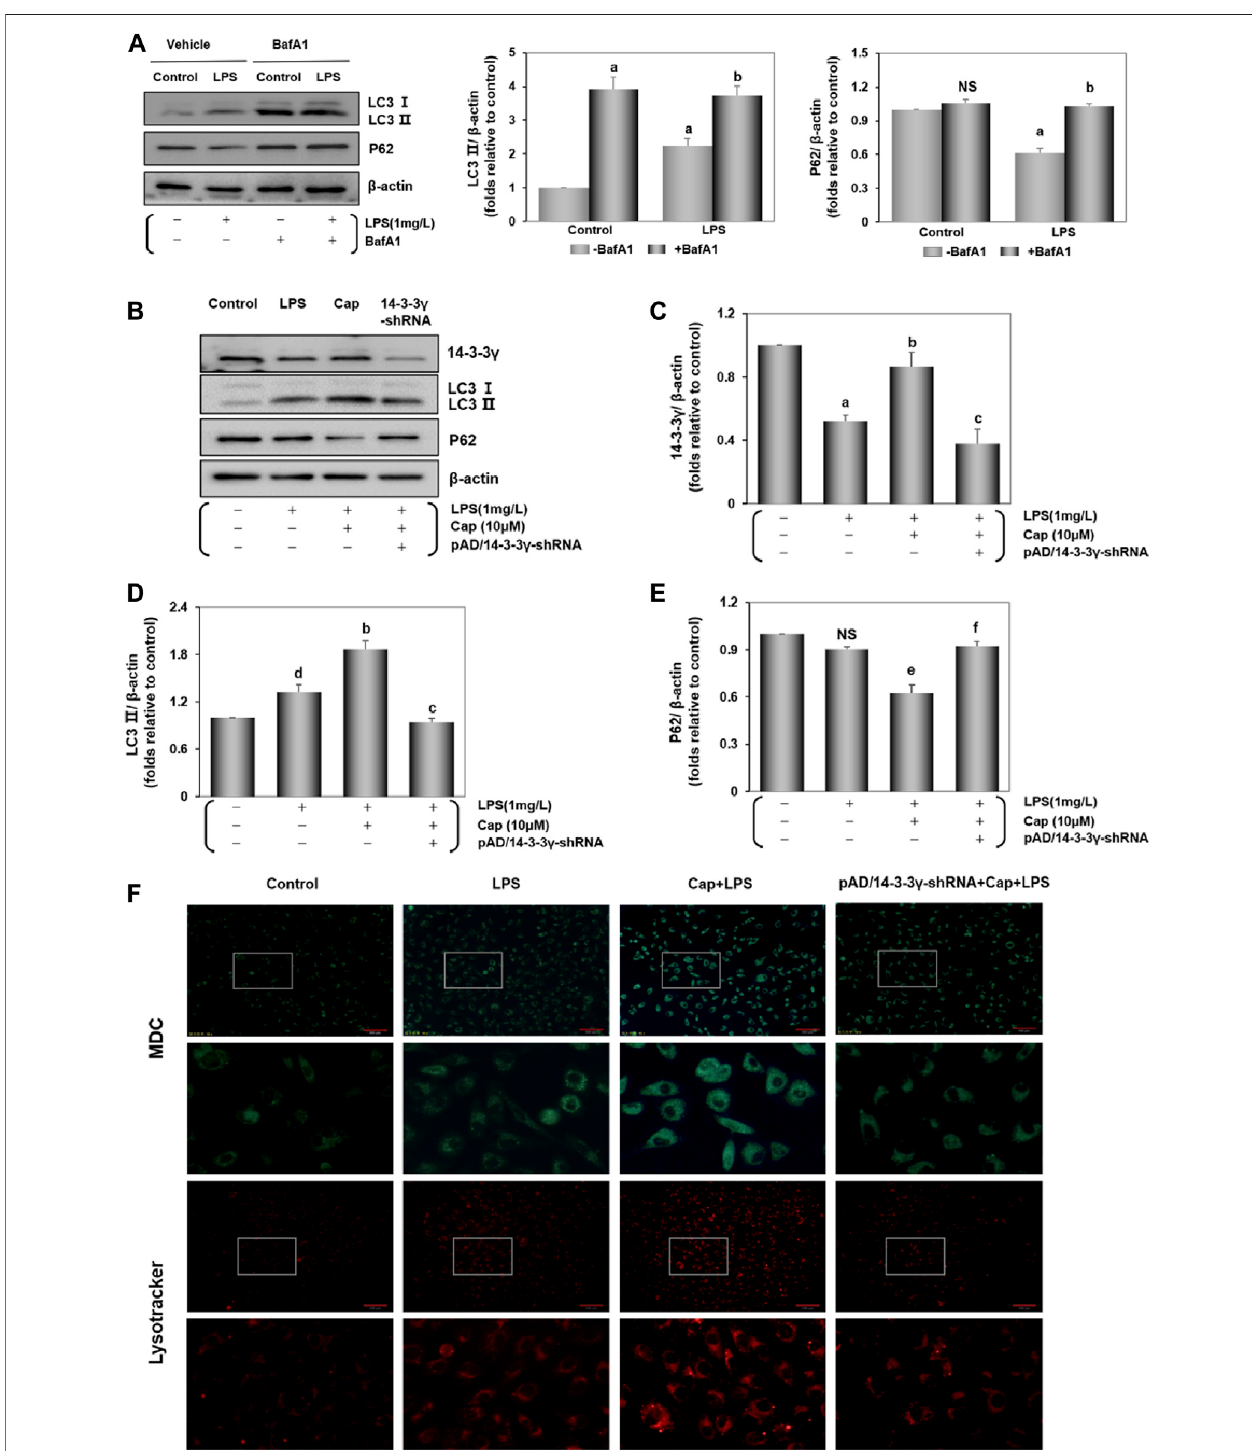
FIGURE 2 | Cap activates cardiomyocyte autophagy against LPS-induced injury. (A) LPS-induced autophagy fl ux con fi rmed by the contrast of P62 and LC3 Ⅱ between cells with and without BafA1 addition. (B) The representative western blot bands of 14-3-3 γ , LC3 Ⅱ , and P62 expression in the cardiomyocytes. (C-E) The relative band intensity of 14-3-3 γ , LC3 Ⅱ , and P62 expression in the cardiomyocytes. (F) Cardiomyocytes incubated with dansylcadaverine (MDC) or LysoTracker Red DND-99. Green or red intensity showed the autophagosome and autolysosomes. Values were presented as mean ± SEM. For fi ve individual experiments, a: P < 0.01 vs. the control group; b: P < 0.01 vs. the LPS group; c: P < 0.01 vs. the Cap+LPS group. d: P < 0.05 vs. the control group; e: P < 0.05 vs. the LPS group; f: P < 0.05 vs. the Cap+LPS group; NS, nonsigni fi cant.